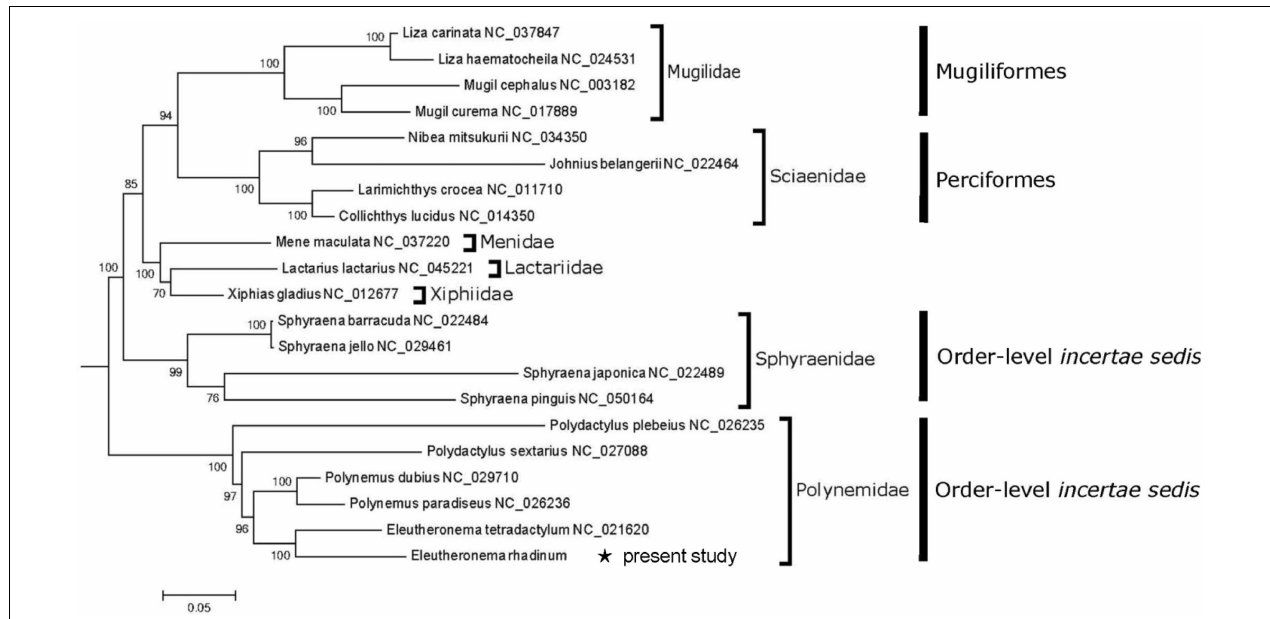
FIGURE 3 | A phylogenetic tree inferred by ML analysis and based on 12 protein-coding genes. Bootstrap values are expressed as percentages and are noted on nodes. * indicates E. rhadinum examined in the present